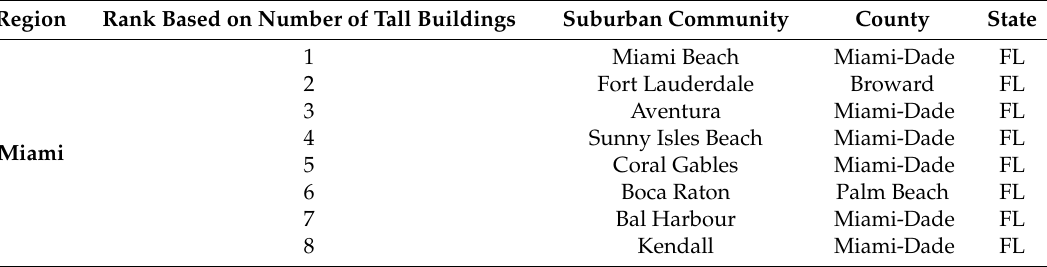
Table 3. The examined suburbs in the Miami Metropolitan